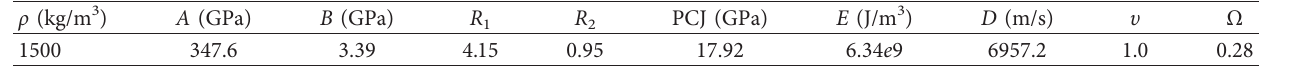
Table 3: Material model parameters and JWL parameters of